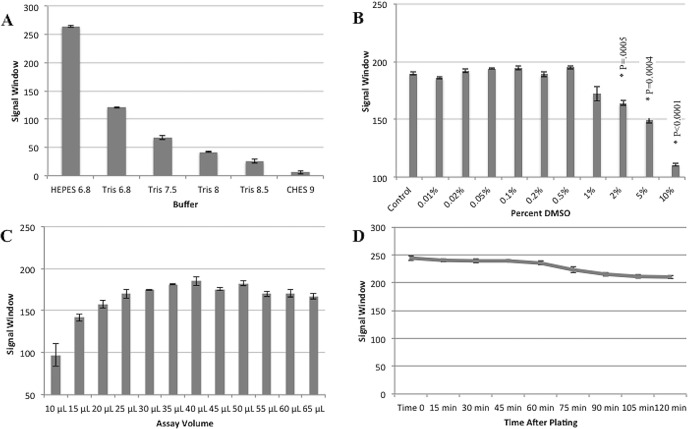
Optimization of FP assay for CHIKV nsP1.In order to determine the optimal pH for the FP assay, purified CHIKV nsP1 was incubated in the indicated buffer types with 10 nM GTP-Bodipy in black plates for 1 hour at 25°C in the dark. (A) Plates were then scanned for FP and signal windows were calculated for each buffer condition. (B) To determine the effect of DMSO concentration on FP assay signal window, purified CHIKV nsp1 was incubated with 10 nM GTP-Bodipy and various concentrations of DMSO ranging from 0.01%-10%. Plates were incubated for 1 hour at 25°C in the dark and then read for FP. (C) In order to determine the optimal assay volume, purified nsP1 was incubated with 10 nM GTP-Bodipy in FP binding buffer with 0.2% DMSO and plated in black plates in decreasing volumes from 65 μL to 10 μL. Plates were incubated for 1 hour at 25°C in the dark, scanned for FP and signal windows were calculated for each volume. (D) In order to determine the stability of the signal window over time, CHIKV nsP1 was incubated with 10 nM GTP-Bodipy at 25°C in the dark. Plates were scanned every 15 minutes for 120 minutes and signal windows were calculated at each time point. n = 3.